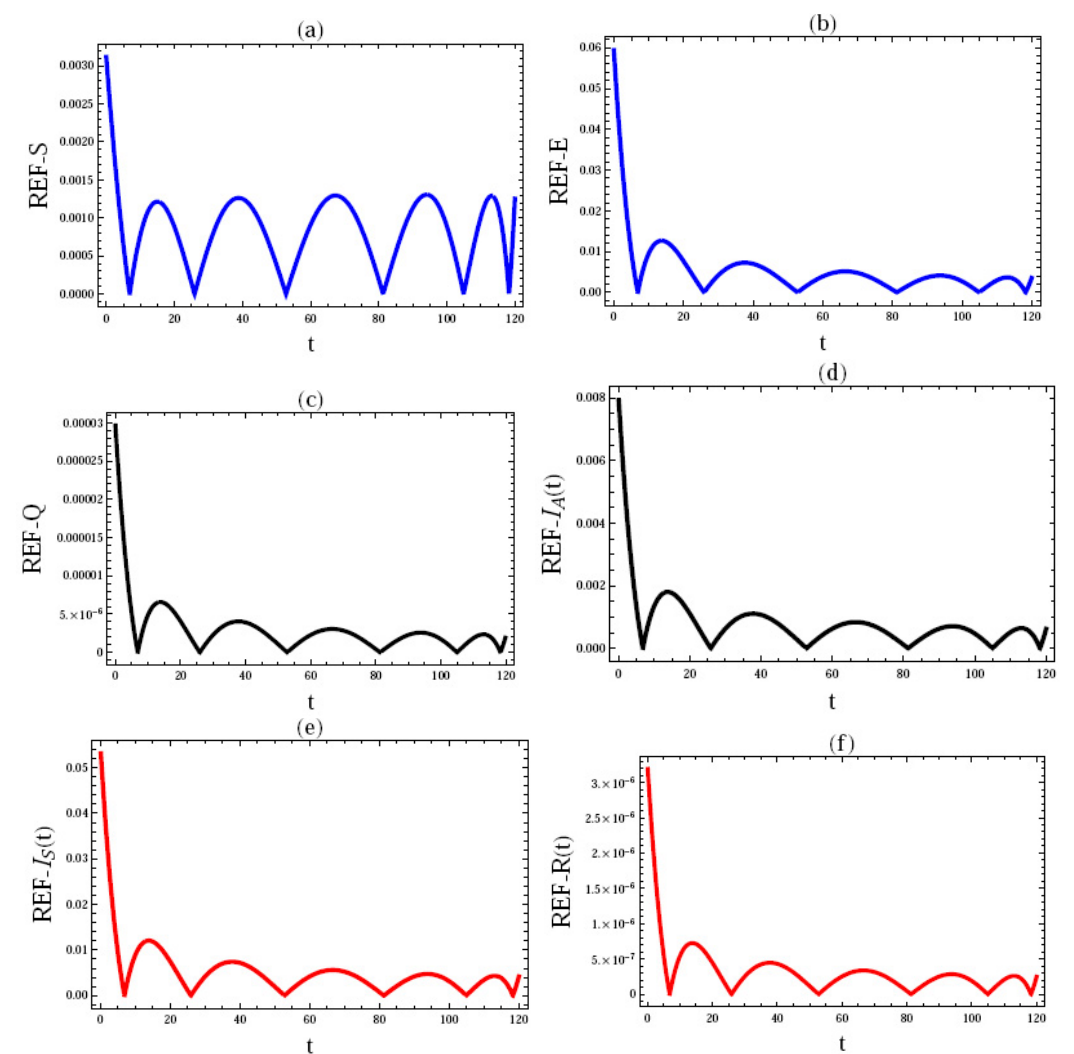
Figure 5. The REF of the approximate solution. ( a – f ) S ( t ) , E ( t ) , Q ( t ) , IA ( t ) , IS ( t ) , R ( t )